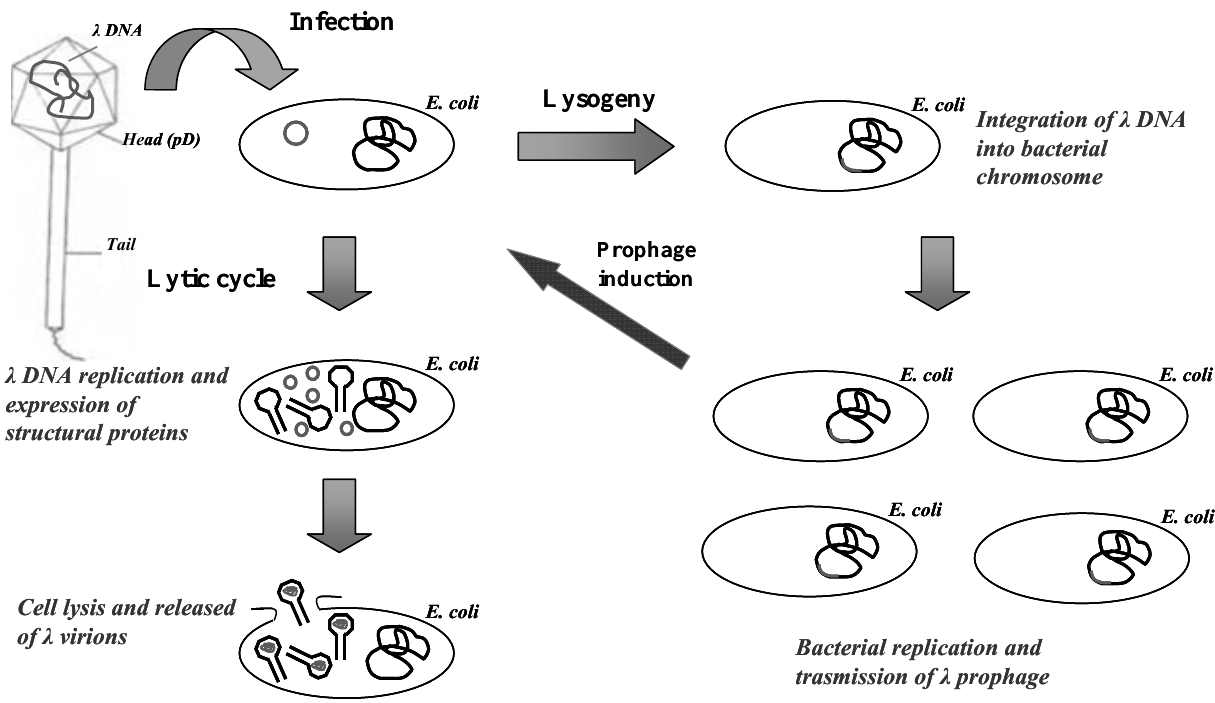
Figure 1. The life cycle of lambda